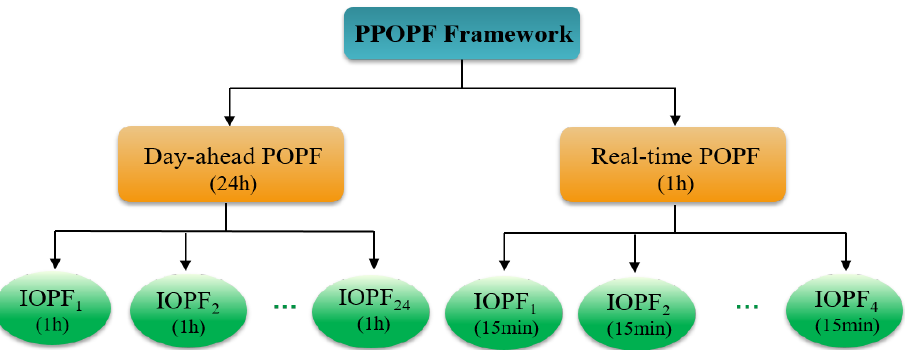
Figure 3. Coherent coordination of the progressive period optimal power flow framework. This diagram shows different sub-components of the framework into multiple time periods over multiple intervals in the overall dispatch hierarchy. The overarching framework is referred to as progressive period optimal power flow